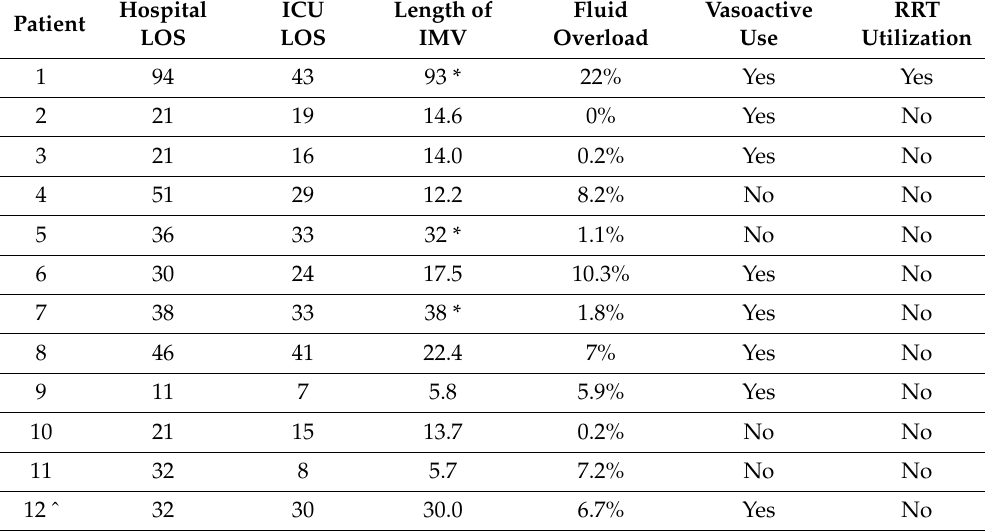
Table 3. Hospital data for each subject included in the case